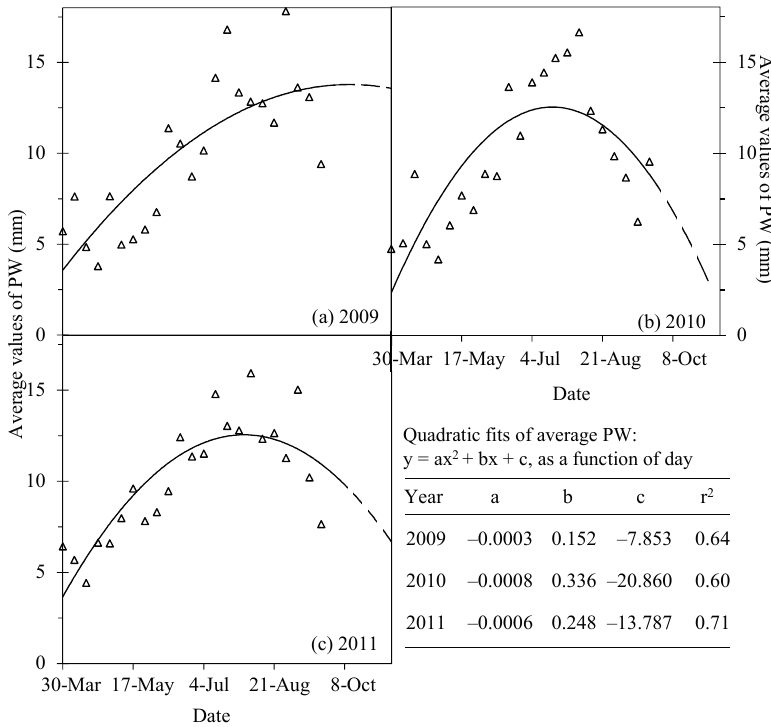
Figure 3. Study area-specific average values of PW ( i.e. , 8-day average) with day for the fire seasons of 2009–2011 ( i.e. , between 30 March to 29 September ( i.e. , DOY 89 and